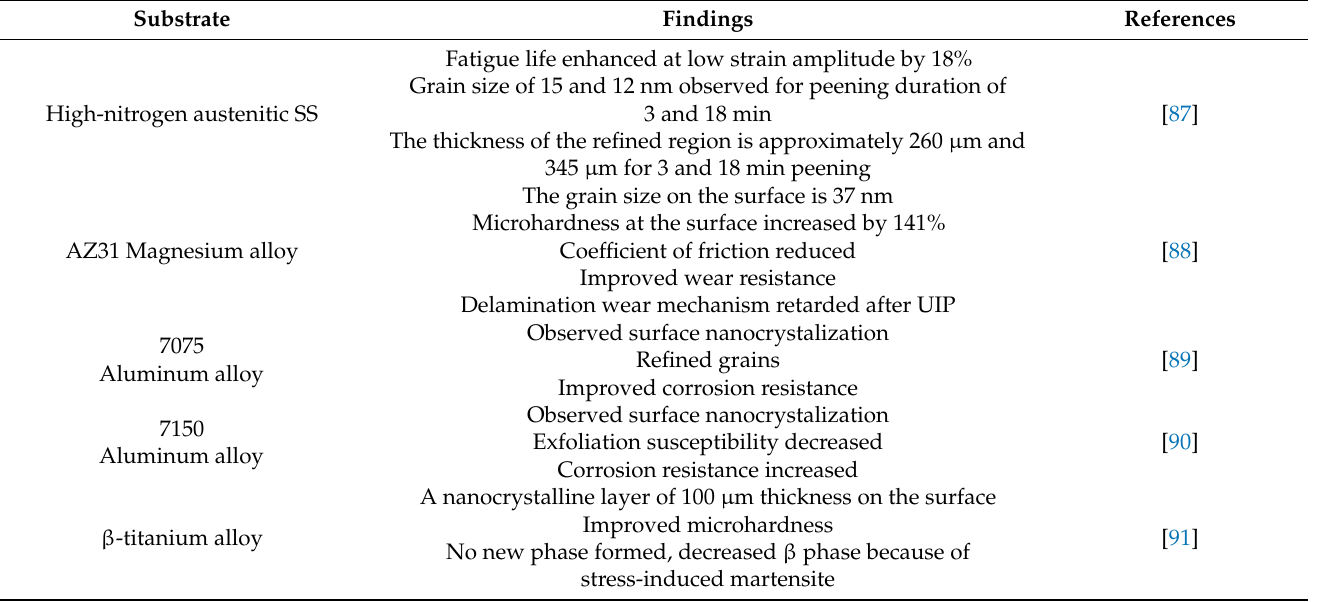
Table 2. Effect of UIP process on various engineering materials.